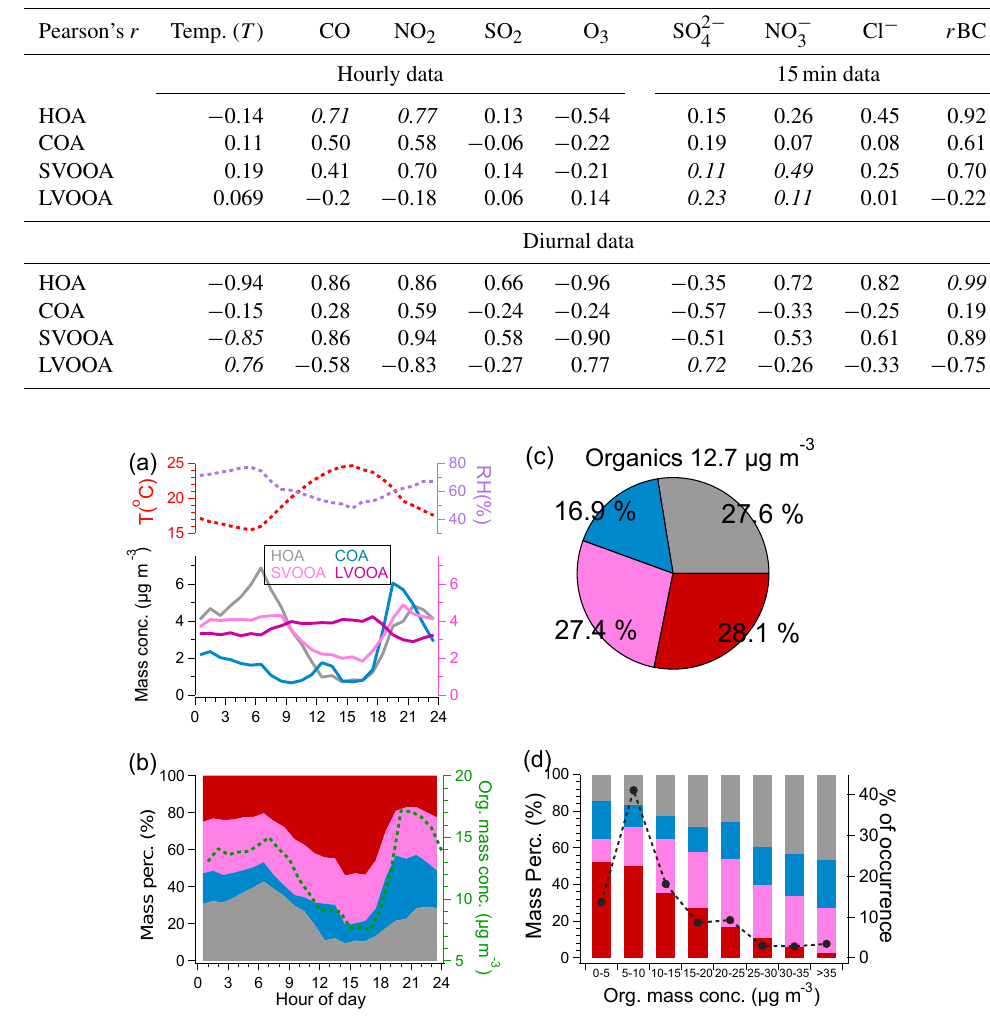
Figure 10. (a) Diurnal cycles of mass concentrations of the four OA factors (bottom panel), temperature (top panel, left y axis) and RH (top panel, right y axis), (b) diurnal variations of mass contributions of the four OA factors (left y axis), and the total OA mass concentrations (right y axis), (c) campaign-averaged mass contributions of the four OA factors to the total OA mass, and (d) mass contributions of the four OA factors (left y axis), and the fractions of the number of data points to the total number of data points for the OA at different concentration ranges (right y